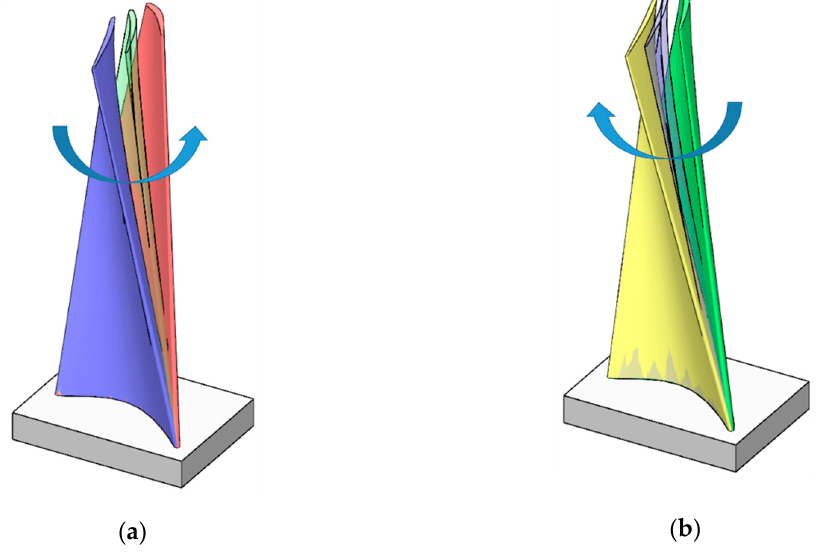
Figure 3. The change in the blade shape during the iteration of the deviation analysis. ( a ) Changes in the cold shape under the aerodynamic load; ( b ) changes in the ideal shape under the reverse load.